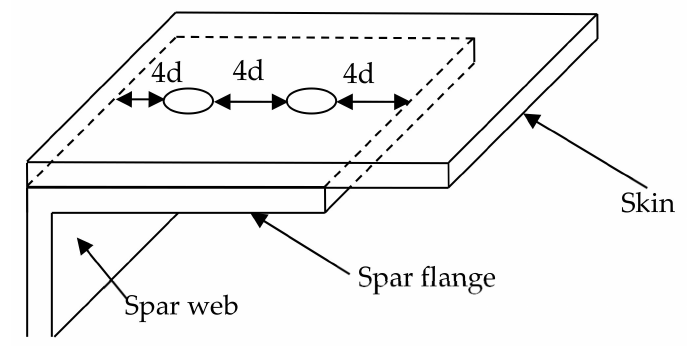
Figure 6. Skin-flange bolted joint